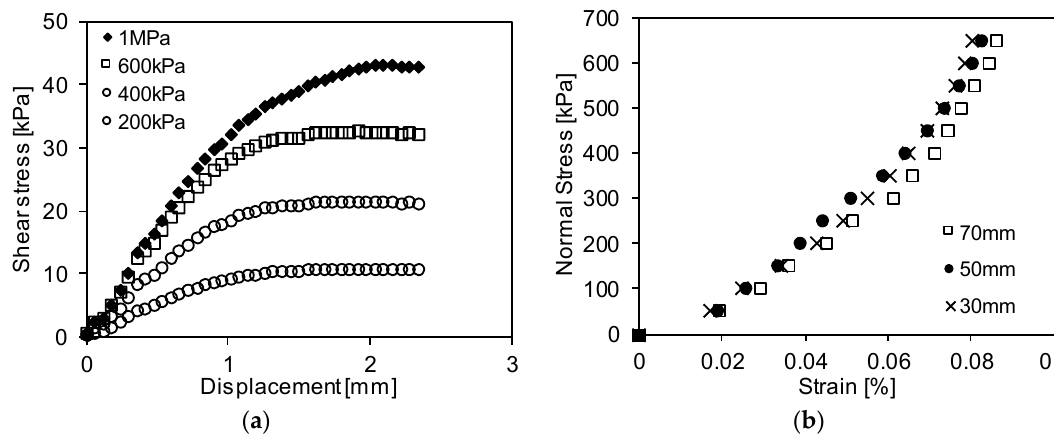
Figure 3. Results of lab-scale tests: ( a ) stress-displacement curve of the consolidation test; ( b ) stress– Figure3. Resultsoflab-scaletests: ( a )stress-displacementcurveoftheconsolidationtest; ( b )stress-strain strain curve of the direct shear test. curve of the direct shear